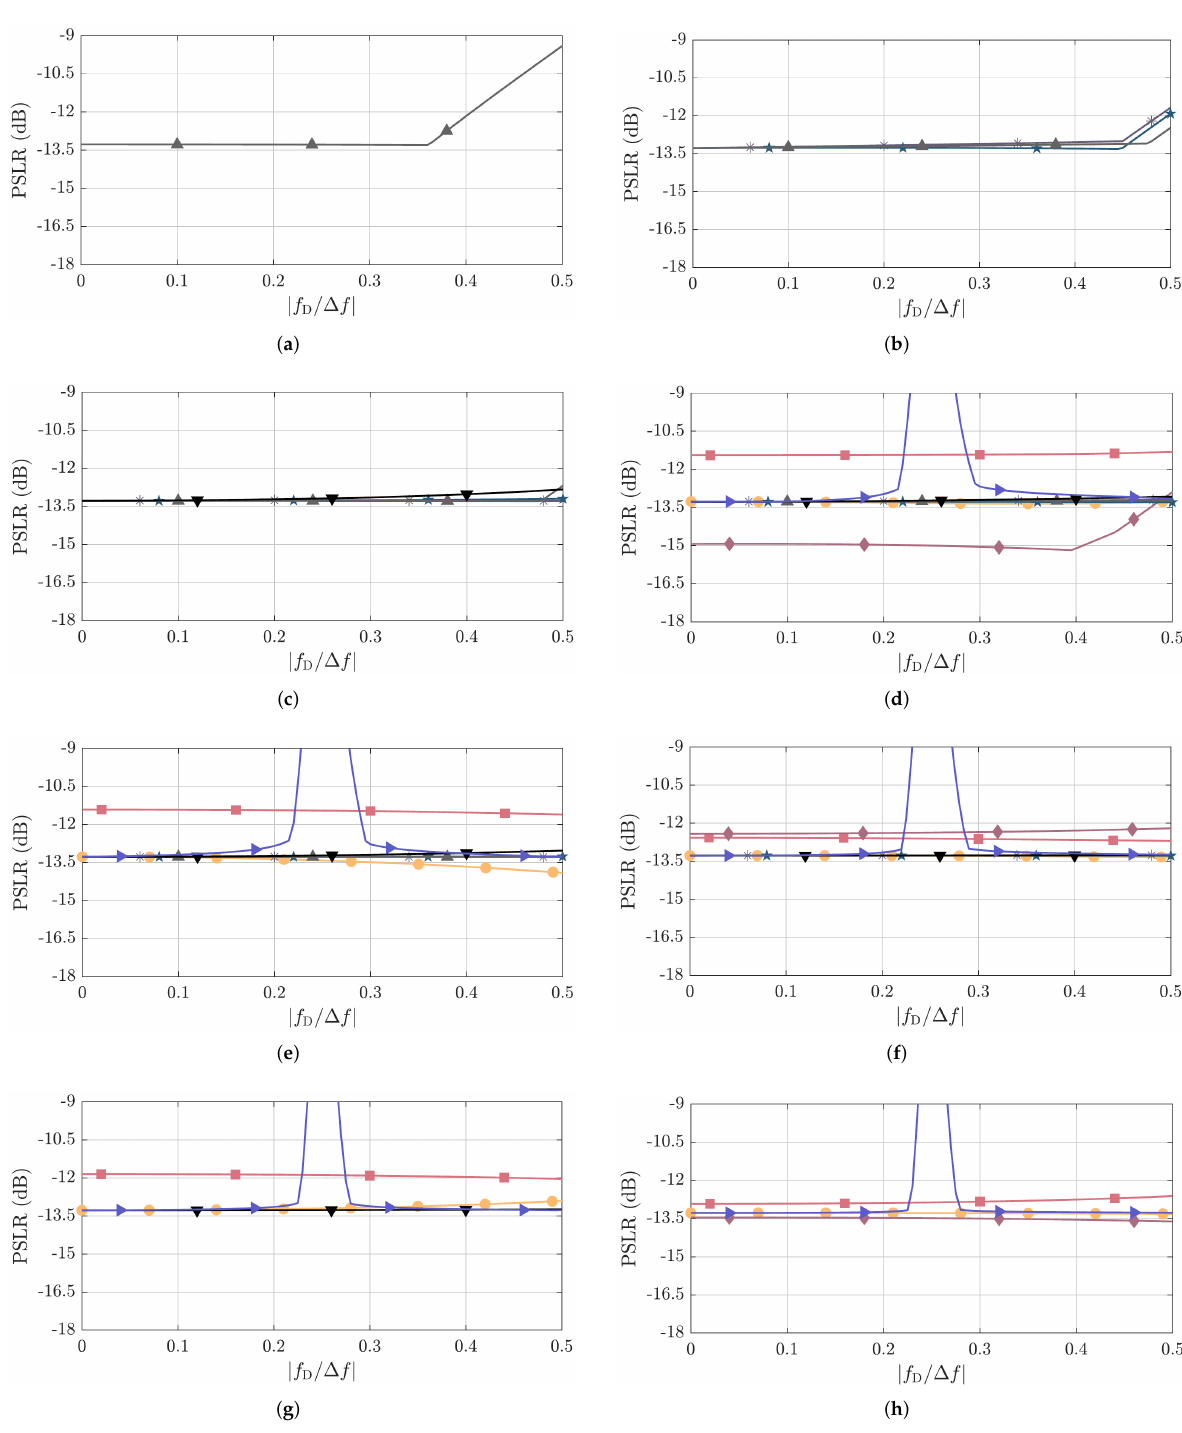
Figure 9. Simulated PSLR as a function of f D / ∆ f for the considered PRBSs with approximate PACF usable length of ( a ) N PRBS,usable = 32, ( b ) N PRBS,usable = 64, ( c ) N PRBS,usable =